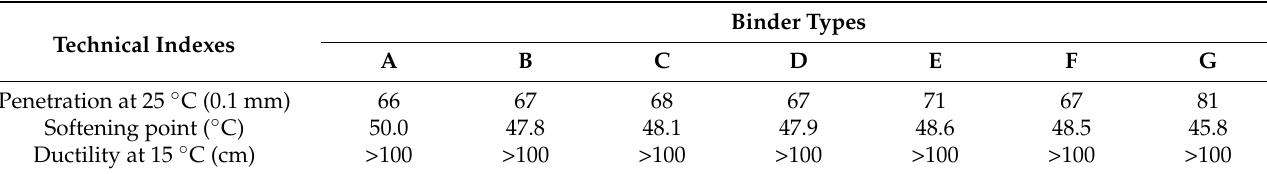
Table 1. Physical properties of all tested